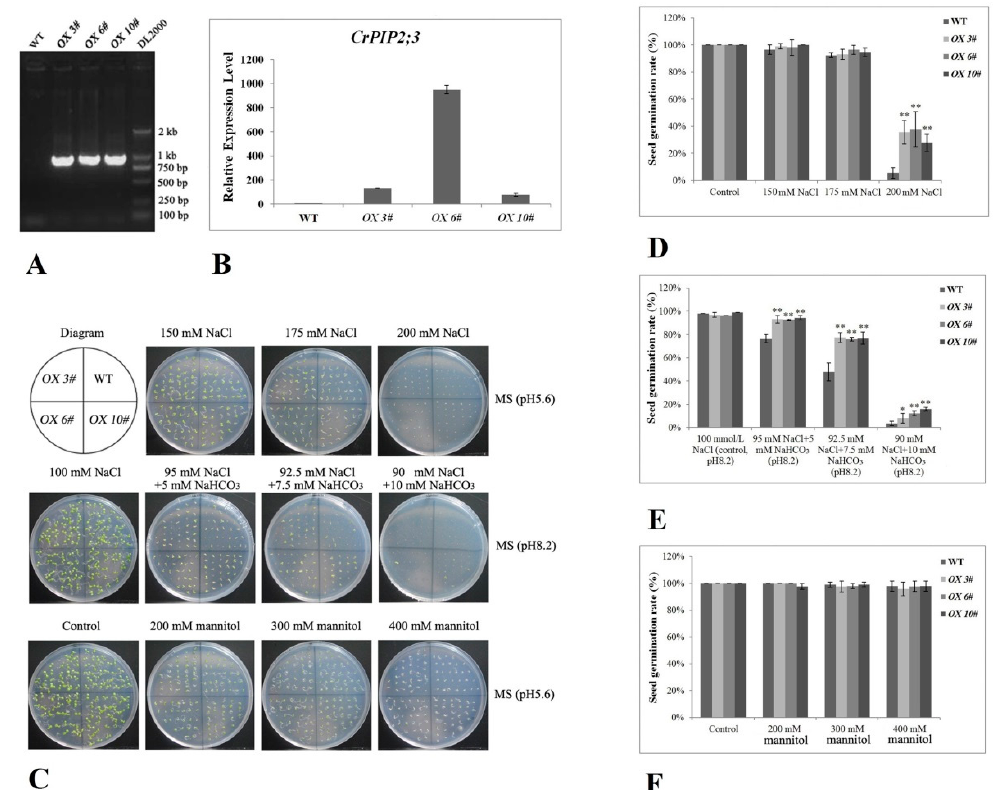
Figure 5. Overexpression analyses of CrPIP2;3 in transgenic A. thaliana lines and stress analyses of transgenic plants with regards to the seed germination rate. ( A ) Genomic PCR analysis of CrPIP2;3 in three transgenic A. thaliana lines ( CrPIP2;3 OX 3# , OX 6# , and OX 10# ) and WT plants; ( B ) quantitative RT-PCR analysis of CrPIP2;3 in transgenic A. thaliana lines and WT plants; ( C ) photographs of transgenic lines and WT seeds germinated on MS medium alone or on MS medium with NaCl, NaCl plus NaHCO 3 (pH 8.2), or mannitol for 7 d; ( D – F ) seed germination rates in WT and transgenic lines under NaCl ( D ), NaCl plus NaHCO 3 (pH 8.2) ( E ), and mannitol ( F ) stresses after 7 d. Error bars indicate the SD based on at least three replicates ( n ≥ 3). Asterisks indicate significant differences from the control (Student’ s t ‐ test, * P < 0.05 and ** P < 0.01).